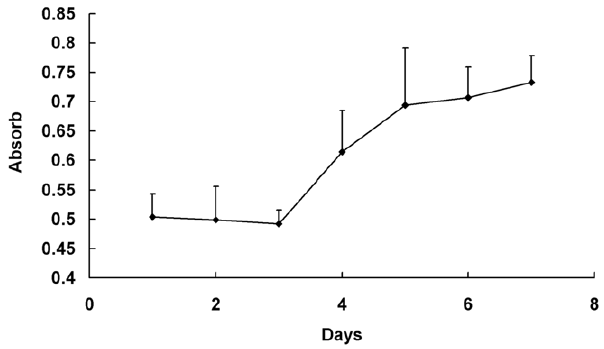
Figure 1. Hepatic stellate cells identification. A. Freshly isolated HSCs were spherical, had strong refraction and suspended in culture medium ( 6 100). B. 10-day primary cultured HSCs were fully spreading, presenting stellate or polygonal forms, granular cells were significantly reduced ( 6 100). C. Cell purity was detected by flow cytometry: freshly isolated HSCs stained by monoclonal anti-desmin and FITC-anti-IgG, and the the positive cells in freshly isolated HSCs were 95.4%. D. Generation 2 HSCs were stained by DAPI: cell nucleus were stained and presented in blue ( 6 600). E. Generation 2 HSCs were stained by GFAP/IgG-TRITC: positive cells were stained and presented in red ( 6 600). F. Generation 2 HSCs were stained by desmin/IgG- FITC: positive cells were stained and presented in green ( 6 600). G. Generation 2 HSCs were stained by GFAP/IgG-TRITC , desmin/IgG-FITC and DAPI: positive cells were stained and the number of HSCs more than 99% ( 6 600).